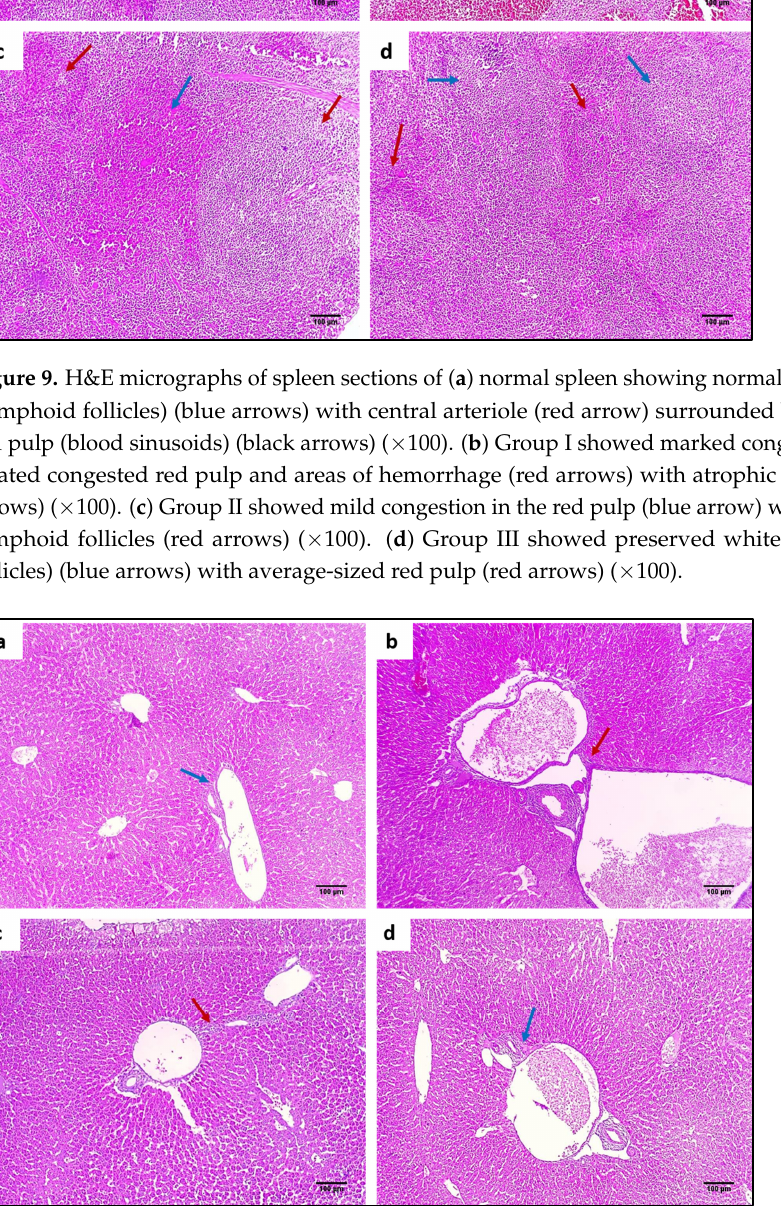
Figure 10. Masson’s trichrome-stained liver sections of ( a ) normal liver showing portal tract with a slight fibrous wall (blue arrow) and no fibrosis (×100). ( b ) Group I showed fibrous expansion of the portal areas with an occasional portal- portal (bridging) (red arrow) (×100). ( c ) Group II showed fibrous expansion of the portal areas with short fibrous septa (red arrow) (×100). ( d ) Group III showed a fibrous expansion of a few portal areas (blue arrow) (×100).